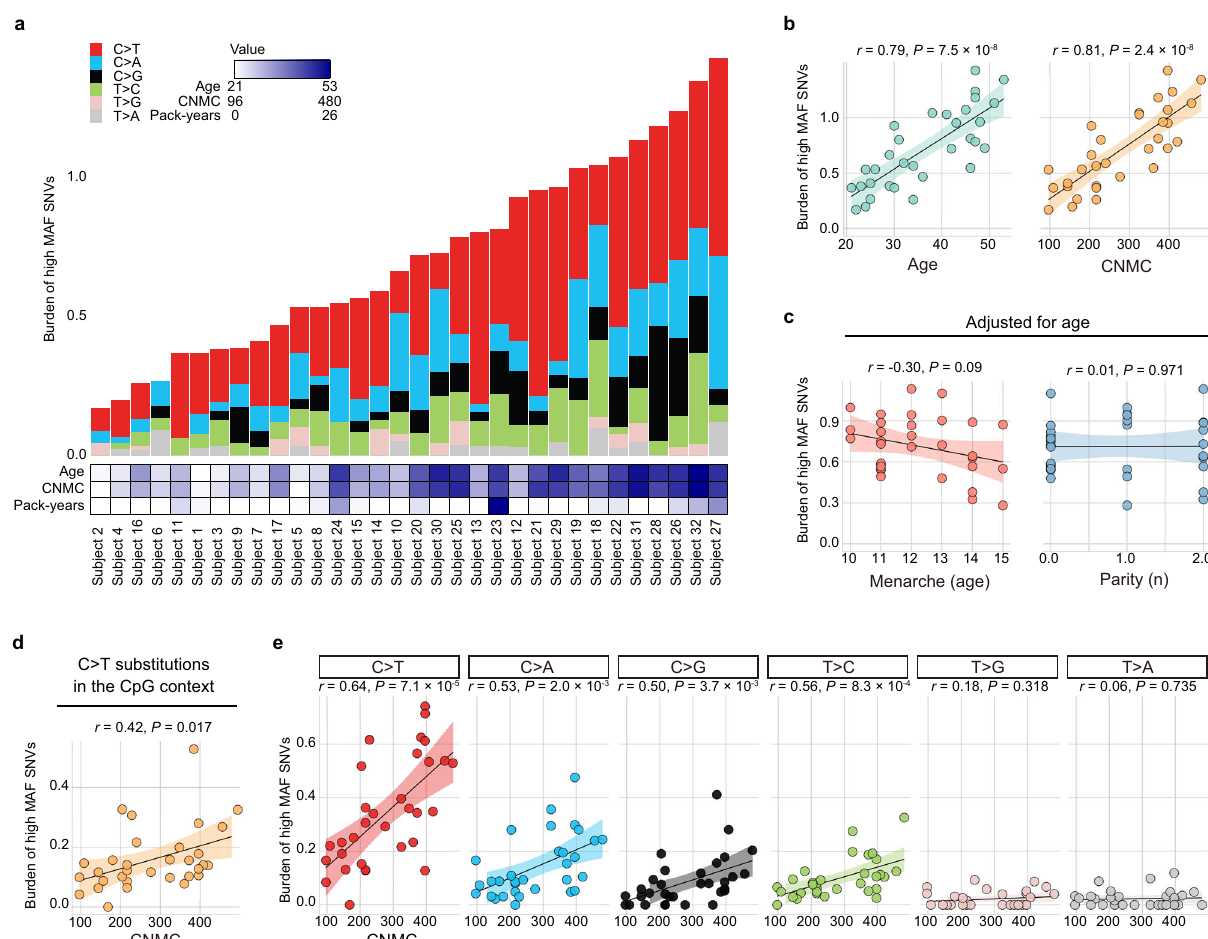
Fig. 2 Burden of somatic mutations accumulates with age and CNMCs. a Bar charts showing the burdens of somatic SNVs with high MAF for 32 subjects stacked by the six pyrimidine substitutions (C>T, C>A, C>G, T>C, T>G, and T>A). The burden is de fi ned as the number of high-MAF SNVs per Mbp sequenced. Multiple glands from an individual subject are pooled. Subjects are sorted in ascending order according to mutation burden. The heatmap below the bar charts represents age, CNMCs, and pack-years of cigarette smoking for the 32 subjects. b Linear relationships of age and CNMCs with the burden of somatic SNVs with high MAF. c Linear relationships of age of menarche and number of parities with the burden of somatic SNVs with high MAF after adjustment for age. d Linear relationship of CNMCs with the burden of C>T transitions at CpG motifs. e Linear relationships of CNMCs with the burdens of the six pyrimidine substitutions. b – e Pearson ’ s correlation coef fi cient ( r ) and the statistical signi fi cance level ( P ) based on two-tailed test are shown. Unadjusted P -value is shown. The slope of a linear regression line (solid line) with 95% CI (shaded area as error band) is plotted. Source data are provided as a Source data fi le. were resected. Each of them was divided into 24 grids with 4 mm regions. Therefore, a plausible explanation may be that at least squares (Fig. 4h). The sequencing of three glands from each grid three mutational events of the FGFR2 mutation occurred showed six and nine clusters with distinct mutations in the independently in the three separated regions of the endometrium anterior and posterior walls, respectively (Fig. 4i – k). Glands in and the mutant clones diversi fi ed at each region by acquiring nine clusters were distributed among multiple neighboring grids, region-speci fi c mutations. suggesting a high level of mosaicism in the endometrium of this More intensive screening was conducted in the endometrium subject. Glands in six clusters had the same mutation of FGFR2 from a 50-year-old subject with myoma uteri, where the 1 cm- (p.S252W). However, WES showed that the glands in different square region was divided into four grids (A to D), and one of clusters did not share any mutations other than FGFR2 them (A) was further partitioned into four subgrids (A-I to A-IV) (p.S252W) (Supplementary Fig. 6f). Additionally, glands in these (Fig. 5a, Supplementary Fig. 6g – i). We extracted 13 or 15 glands six clusters were localized in spatially separated regions of the from each of the subgrids and 20 glands from the remainder of endometrium: Cluster 3 was distributed in the center of the the grids (B, C, and D). We identi fi ed fi ve clusters: two were anterior wall, cluster 12 was in the upper right of the posterior limited to within a grid or subgrid, and the other three were wall, and clusters 8, 13 – 15 were in the lower left of the posterior prevalent among multiple grids and subgrids (Fig. 5b, c). Two wall (Fig. 4i). It is not likely that the FGFR2 mutation initially clusters (1 and 3) accounted for 18 glands spreading across three occurred in a single ancestral clone and the ancestral clone grids (B, C, and D) and one subgrid (A-IV) and 16 glands expanded to these three separated regions as depicted by the spreading across two grids (C and D), respectively. Cluster 3 had phylogenetic tree (Fig. 4l), because glands with the FGFR2 a frameshift insertion in PTEN with high MAF (>0.5), implying mutation were not detected in regions connecting the three an allelic imbalance at PTEN , which is known to occur frequently NATURE COMMUNICATIONS| (2022) 13:943